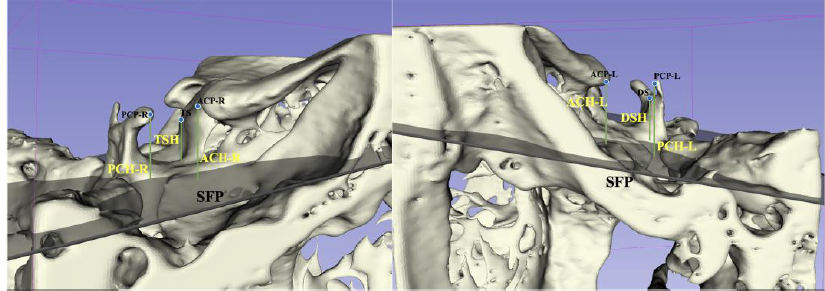
Figure 3. Sella turcica linear dimensions based on CBCT. TSH: tuberculum sellae height; PCH-R: posterior right clinoid height; ACH-R: anterior right clinoid height; PCH-L: posterior left clinoid height; ACH-L: anterior left clinoid height; DSH: dorsum sellae height; ACP-R: the apex of the anterior clinoid process on the right side; ACP-L: the apex of the anterior clinoid process on the left side; PCP-R: the apex of the posterior clinoid process on the right side; PCP-L: the apex of the posterior clinoid process on the left side; DS: the dorsum sellae point; TS: tuberculum sellae; PPF: the most posterior point of the posterior wall of the sella turcica; SFP: sella floor plane.